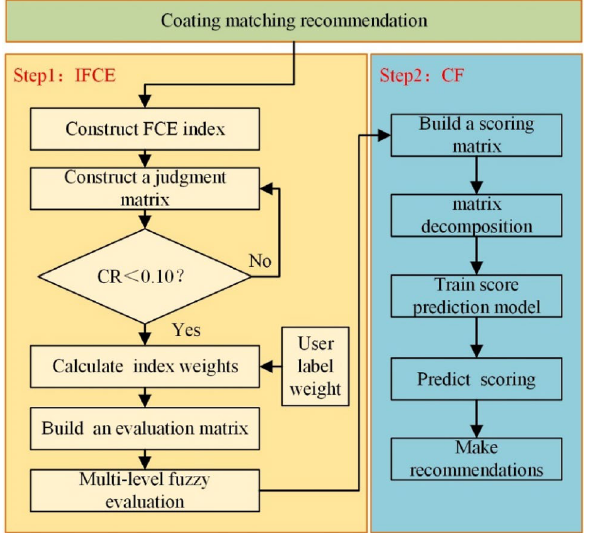
Figure 3. Algorithm flow